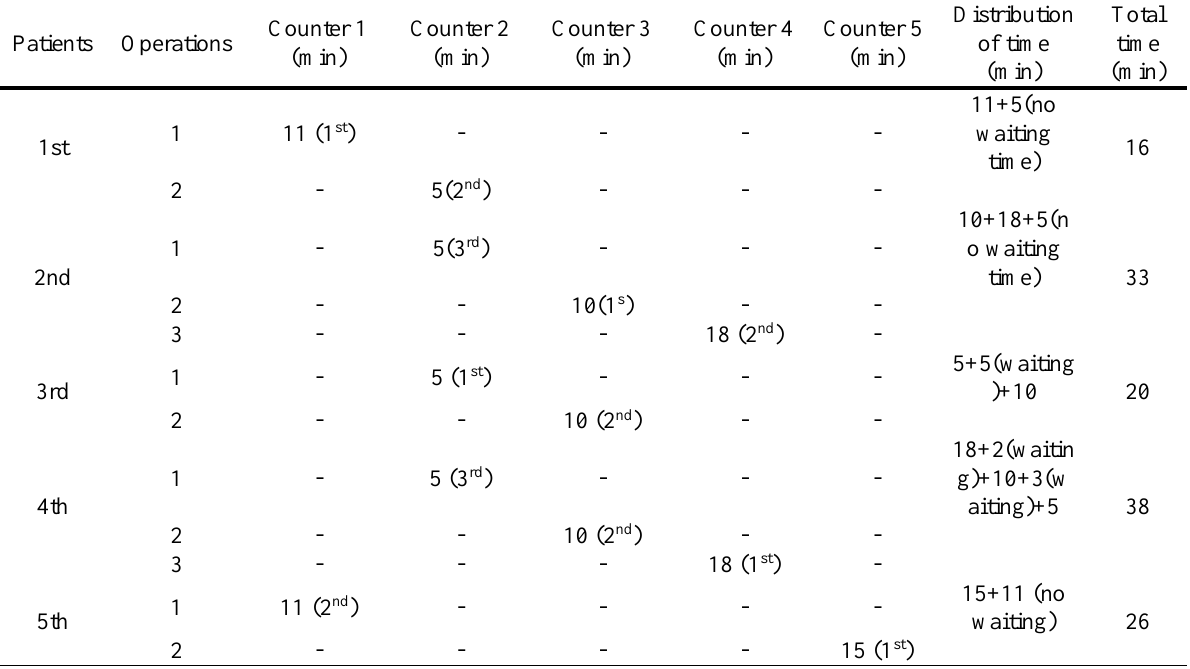
Table 2. Experimental